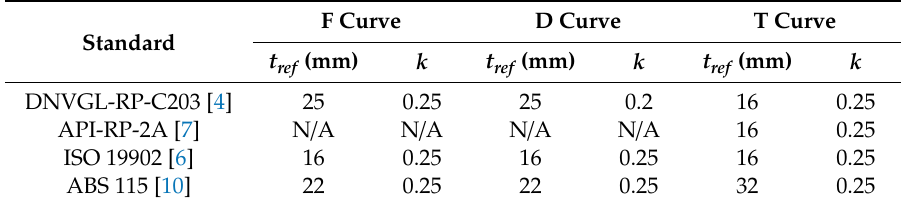
Table 1. Reference thickness and power exponent in various standards.